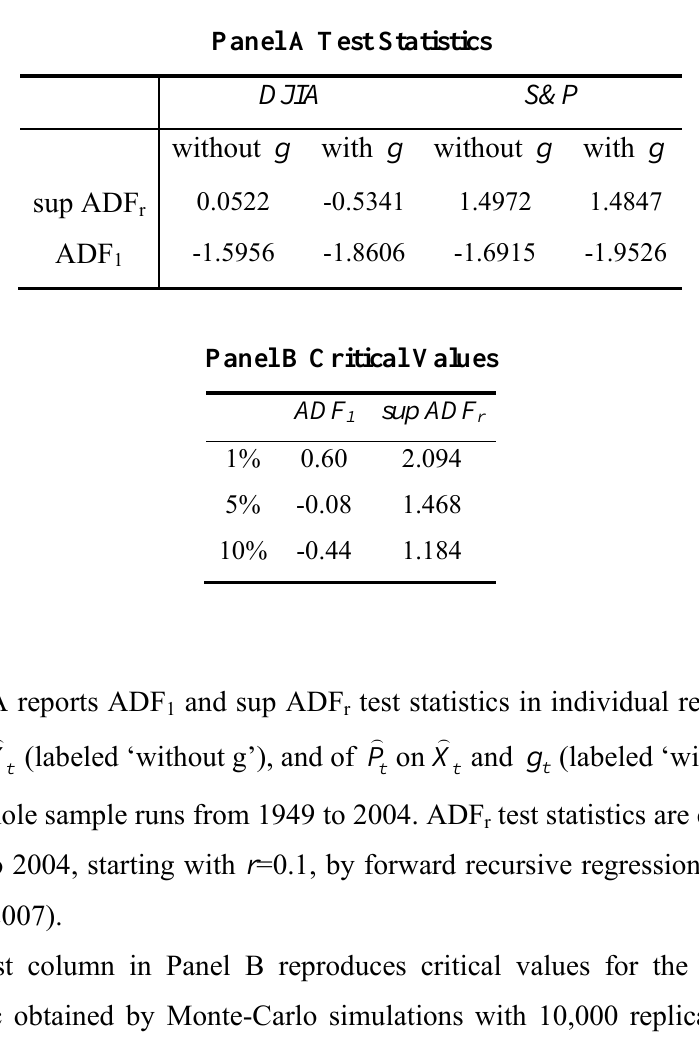
Table 7 Periodically Collapsing Bubbles